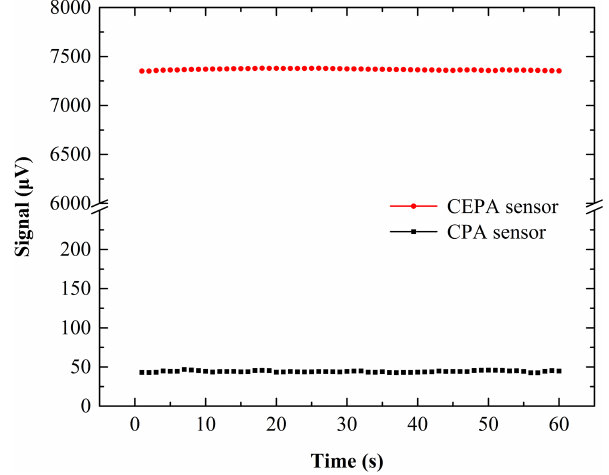
Figure 6. Comparison between the CEPA and CPA signal ampli- tudes from a 500ppmV C 2 H 2 / N 2 gas